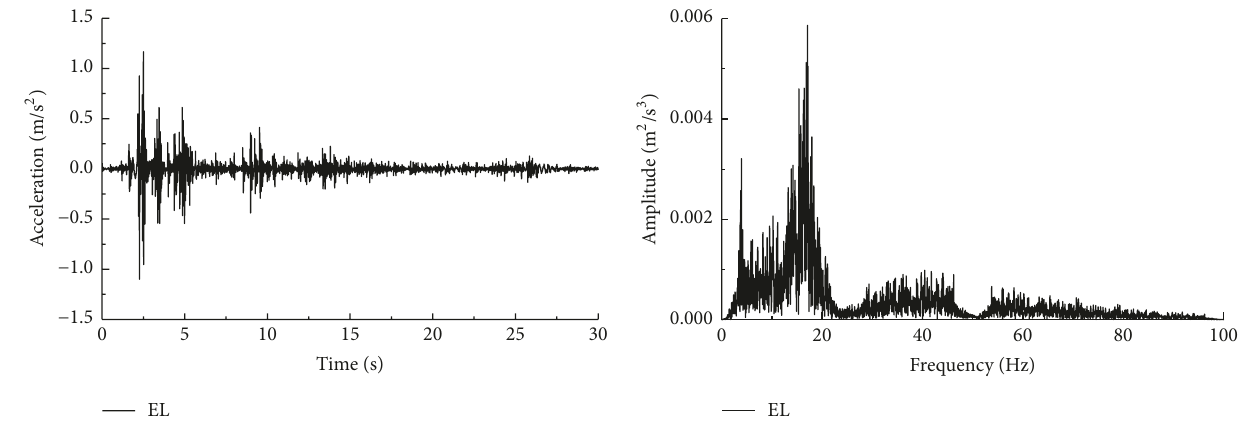
Figure 23: Vertical acceleration time history and Fourier spectrum curves at node 103 under EL wave (HV case).